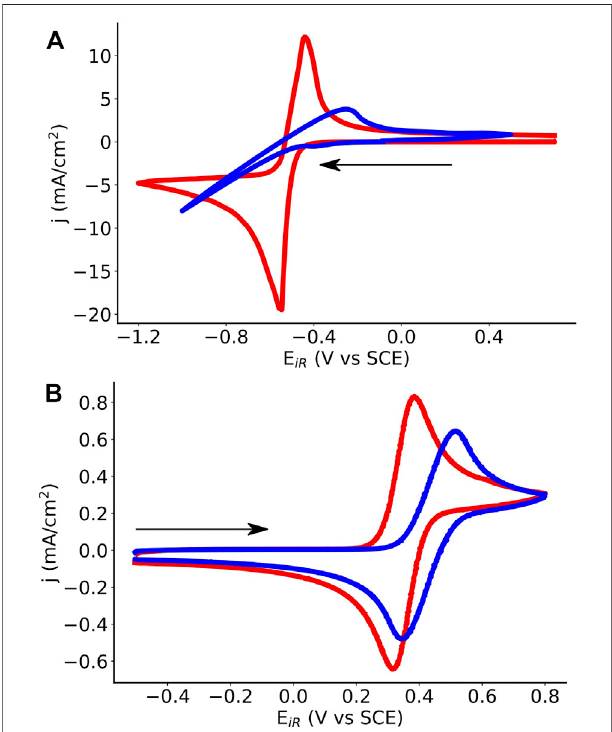
FIGURE 6 | Cyclic voltammograms comparing SDS (red) and polysorbate 20 (blue) microemulsions for (A) menadione negolyte and (B) ferrocene posolyte solutions. SDS microemulsions are 54% 0.5 m KNO 3 (aq), 28% toluene, 9% SDS, and 9% 1-butanol, by mass. Polysorbate microemulsions are 22% 2 m KNO 3 (aq), 31% toluene, 39% polysorbate 20, and 8% 1-butanol, by mass. Menadione concentrations are 0.13 M in SDS and 0.3 M in polysorbate microemulsions. Ferrocene concentrations are ~5 mM in SDS and polysorbate microemulsions. Voltammograms were recorded using glassy carbon working electrodes, saturated calomel reference electrodes, and Pt wire counter electrodes using a scan rate of 50 mV · s − 1 . Sweep direction is indicated by the arrow.